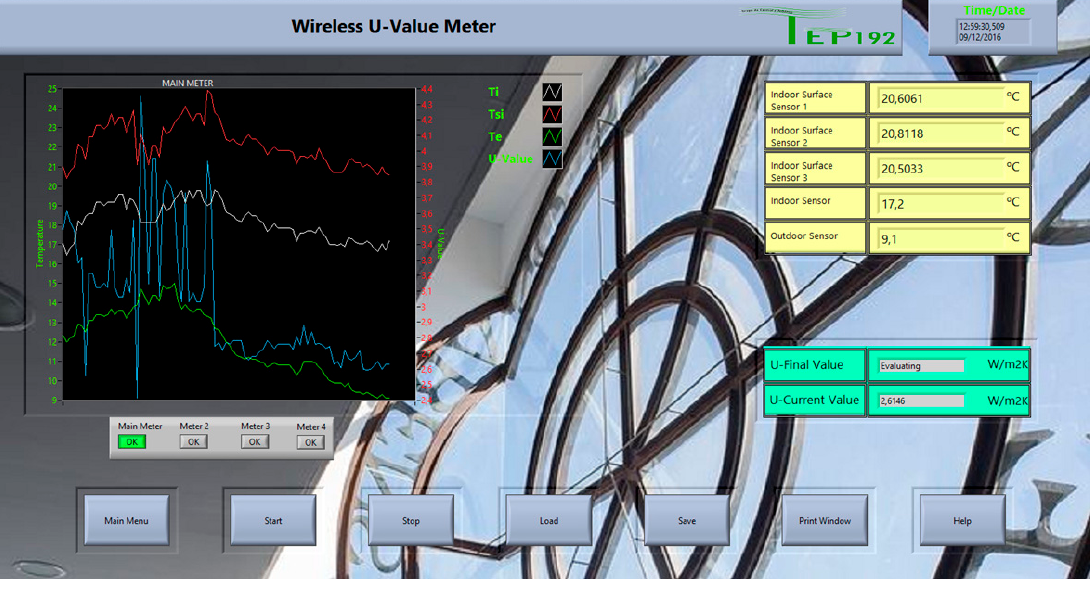
Figure 8. User interface front panel.